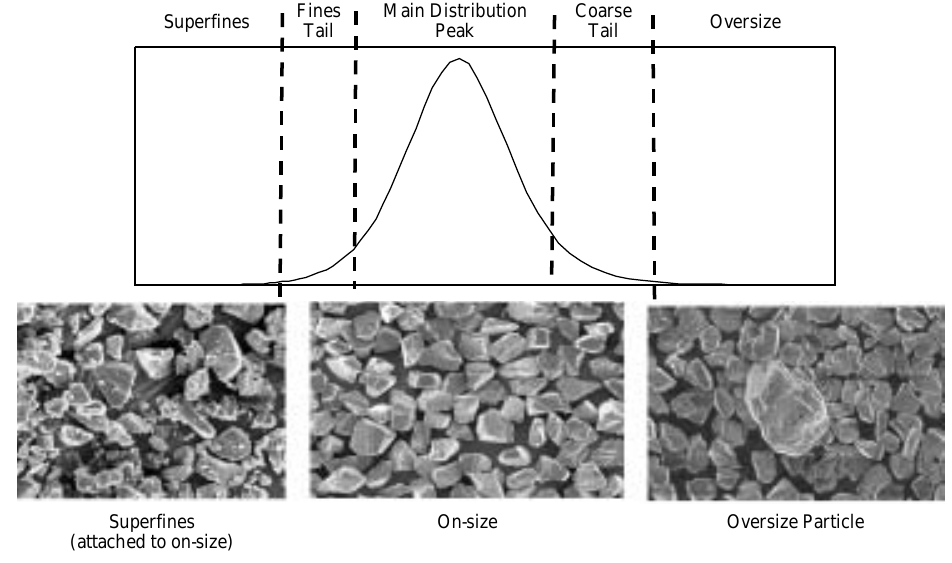
Schematic of a typical particle size distribution curve showing the major zones that affect powder